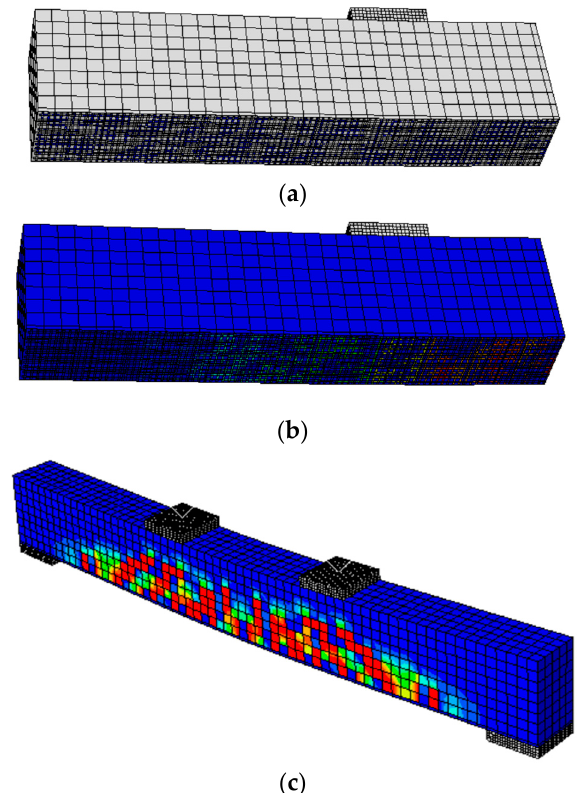
Figure 6. Typical failure mechanisms of beams with mechanical end anchorage: ( a ) zero slippage of CF mesh, ( b ) stress distribution in the CF mesh layer (MPa), ( c ) the flexural cracks distributed in the concrete beam.